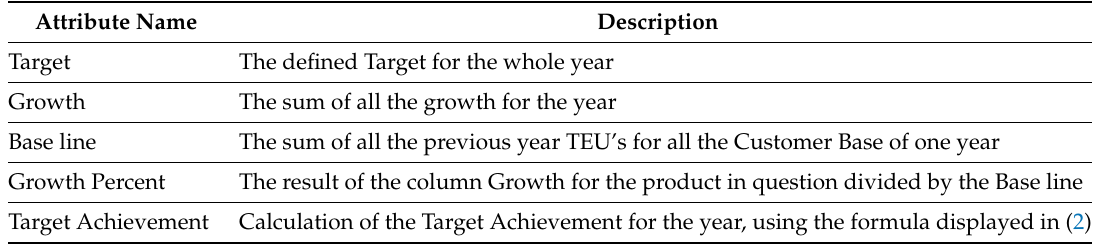
Table 2. Product attributes description.